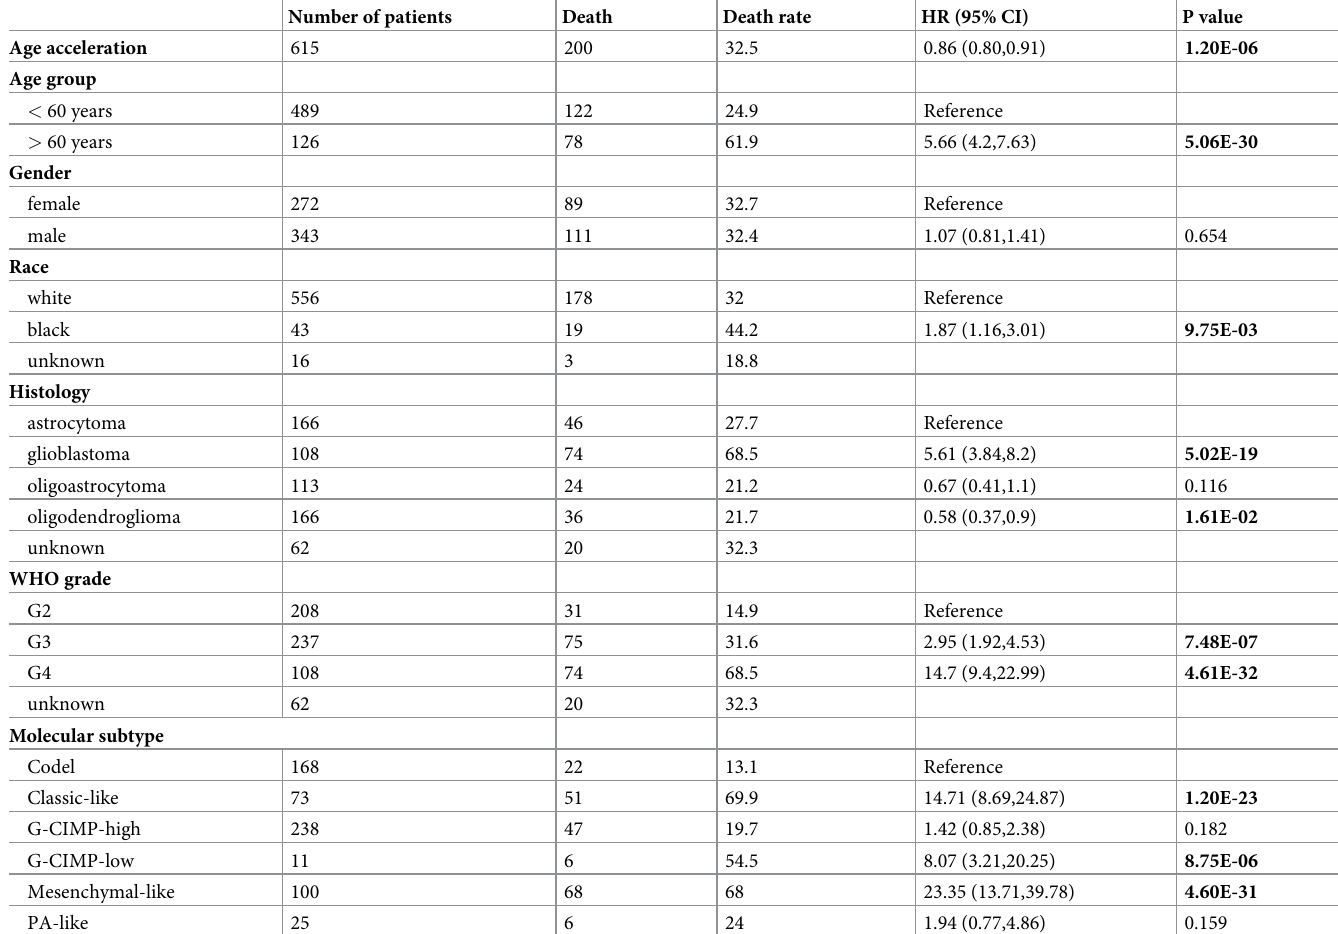
Table 3. Overall survival of gliomas patients in univariate